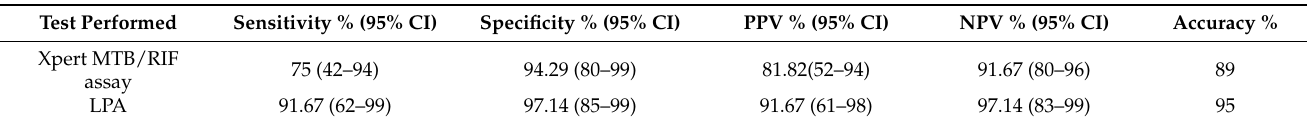
Table 4. Performance of Xpert MTB/RIF assay and LPA in detecting rifampicin resistance, as compared to gold standard conventional drug susceptibility